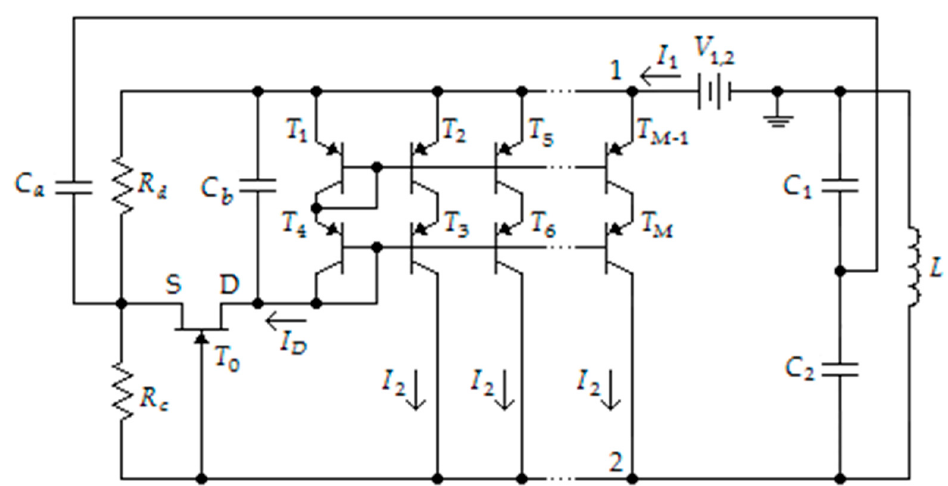
Figure 6. NDR oscillator with multiple-output cascode current mirror.